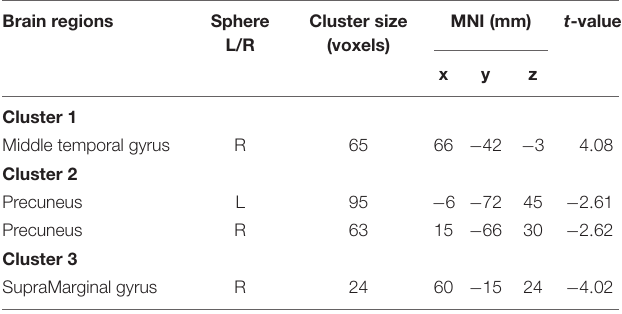
TABLE 2 | Group differences in dALFF between EOS patients and